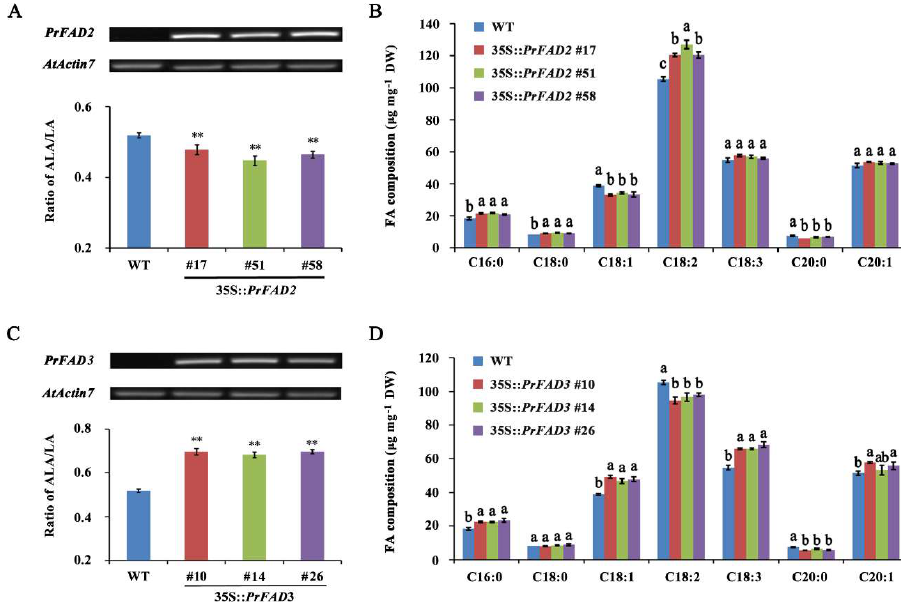
Figure 9. Overexpression of PrFAD2 and PrFAD3 in the wild-type Arabidopsis seeds. ( A ) Figure 9 Semi-quantitative RT-PCR and ALA/LA ratio, and ( B ) FA composition analyses of 14 days wildtype and 35S:: PrFAD2 (#17, #51 and #58) seeds. ( C ) Semi-quantitative RT-PCR and ALA/LA ratio, and ( D ) FA composition analyses of 14 days wildtype and 35S:: PrFAD3 (#10, #14, and #26) seeds. AtActin7 was used as an endogenous control for semi-quantitative RT-PCR. The asterisks indicate significant differences (** p < 0.01; Student’s t -test). Different small letters indicate significant differences at p < 0.05